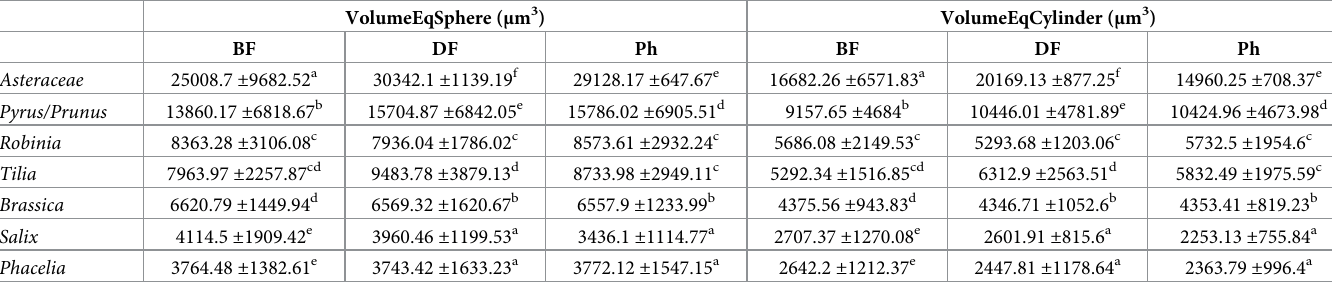
Table 6. Volume descriptors.